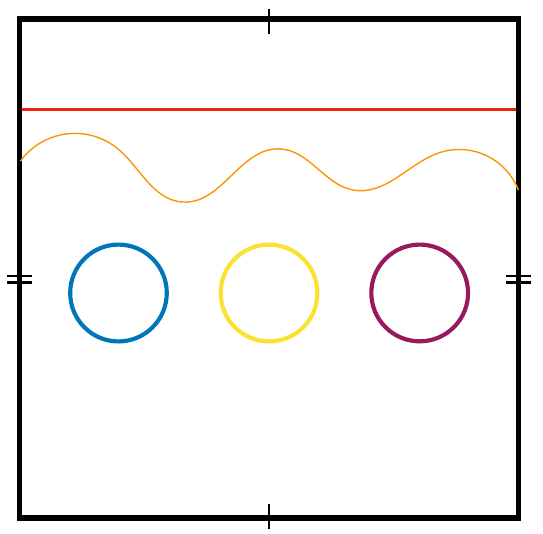
Figure 14 . Picking an element of σ as our antiloop l we can perform a direct dualization on P of the minimization program for Σ P